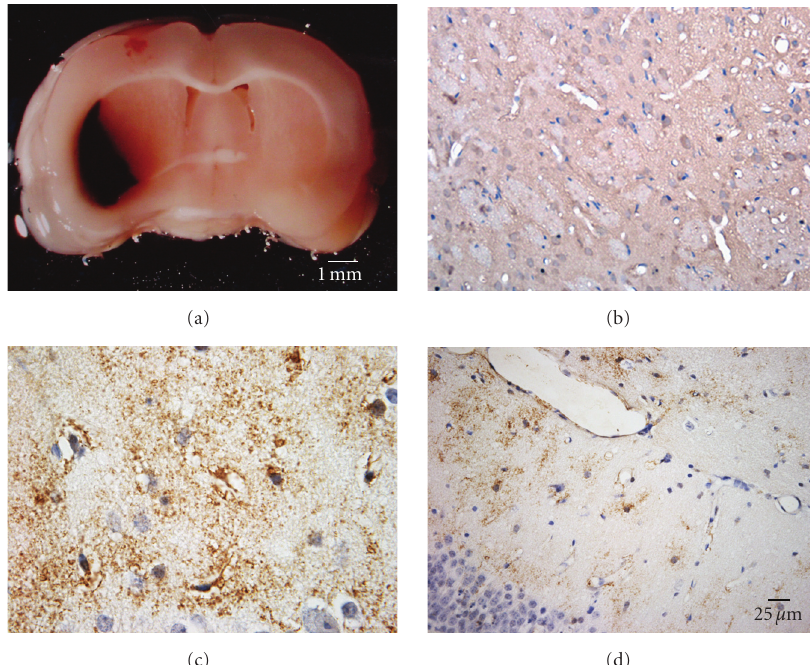
Figure 3: T he distribution of TLR4 protein in brain tissue after ICH . Immunohistochemistry staining for TLR4 was performed on brain sections. Figure 3(a) showed the brain section of the model of ICH. Results from the immunohistochemistry staining showed that TLR4 immunoreactivity was not detectable in brain tissue from normal and sham control (Figure 3(b)). However, immunoreactivity for TLR4 was consistently demonstrated in peri-hemorrhage areas, the hippocampus, cortex, thalamic nuclei, and some white matter tracts (Figures 3(c) and